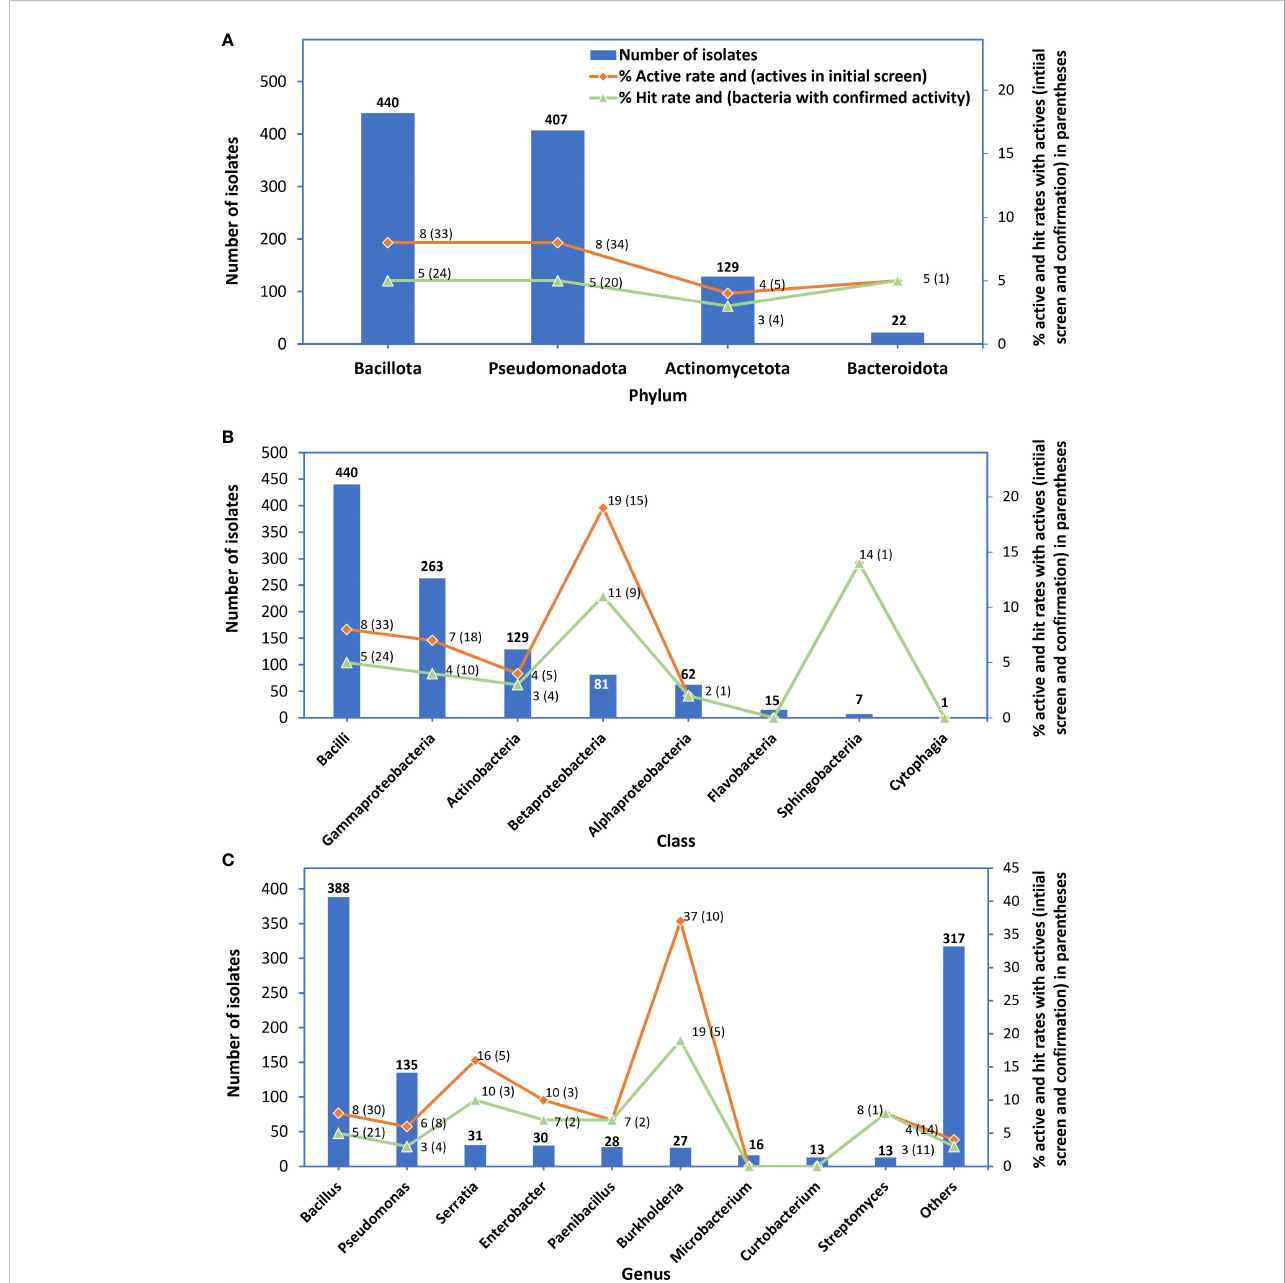
FIGURE 4 Numbers of bacterial isolates tested in the initial screen (bars), % active rates (red lines) and in parenthesis: numbers of active isolates from the initial screen, and % hit rate (green lines) and in parenthesis: numbers of bacteria with con fi rmed activity. Graph (A) represents phyla, (B) class, and (C) genus isolates belonged